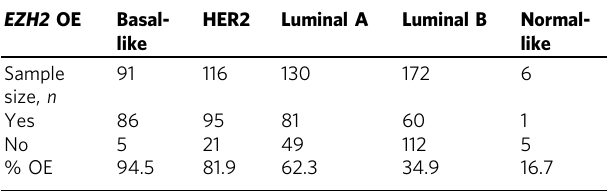
Table 1 Overexpression of EZH2 in breast cancers